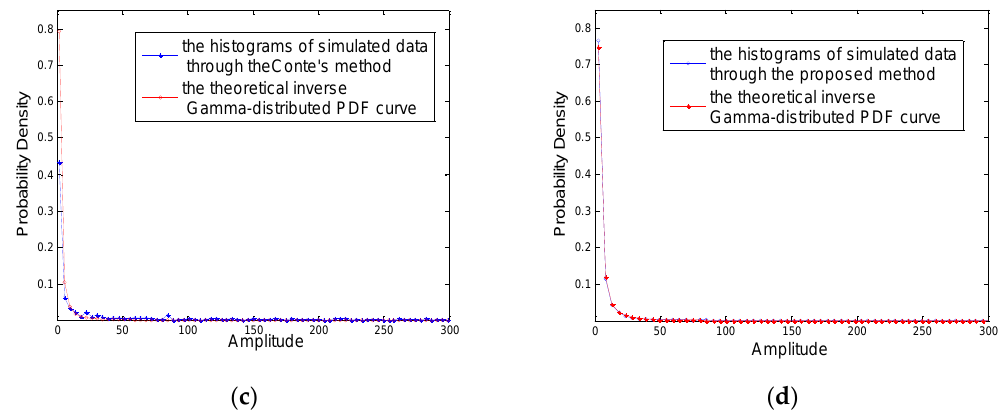
Figure 4. Theoretical Gamma and inverse Gamma PDFs and averaged histogram of the simulated data. ( a ) the simulated data of Gamma distribution through Conte’s method. ( b ) the simulated data of Gamma distribution through the proposed method. ( c ) the simulated data of inverse Gamma distribution through Conte’s method. ( d ) the simulated data of inverse Gamma distribution through the proposed method.